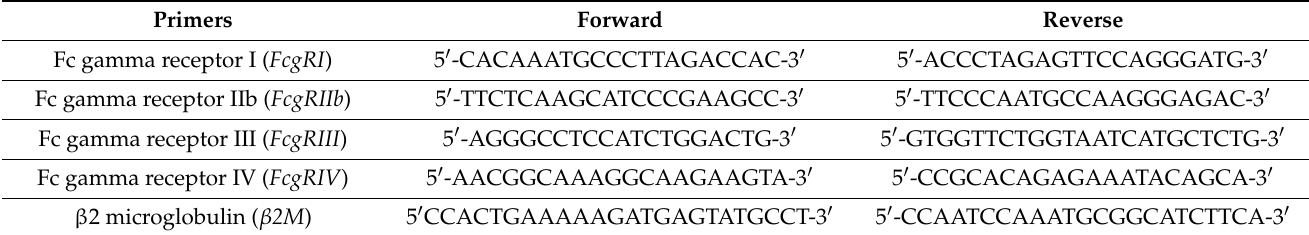
Table 1. List of primers in the study are demonstrated.